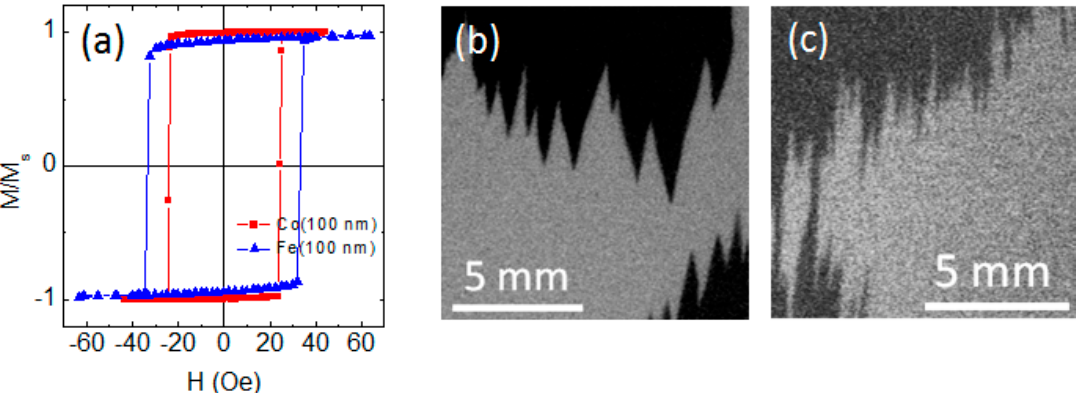
Figure 7. Hysteresis loops measured along easy magnetization axis for Fe (100 nm) and Co (100 nm) films ( a ). Images of the magnetic domain structure for Fe film ( b ) and Co film ( c ) obtained near H c after magnetization of the samples to saturation along the easy magnetization axis (EA). The application axis of the external field is parallel to the EA and vertical sides of the images.